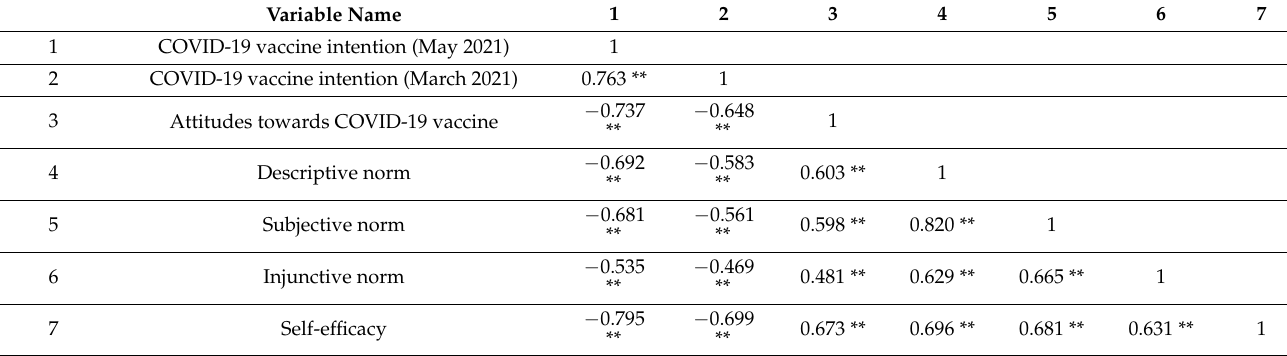
Table 2. Correlations between key constructs.